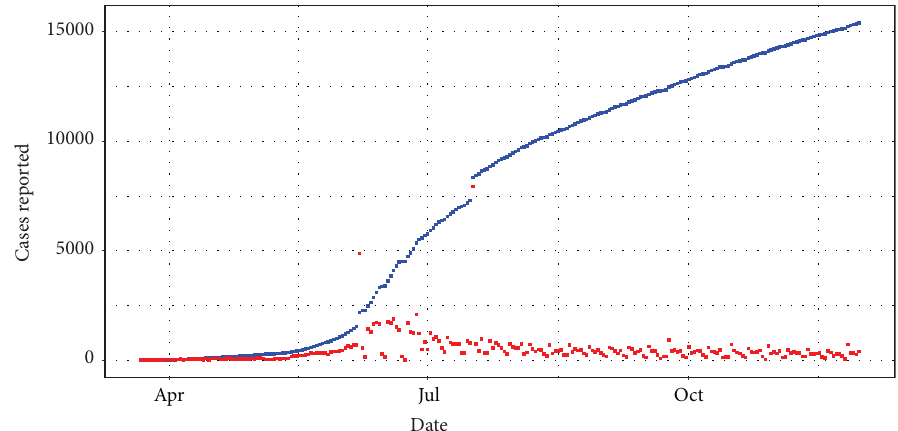
Figure 2: Cumulative and daily number of deaths from COVID-19 in Chile from March 22 to November 30, 2020. Cumulative death cases are shown in blue. In red, the daily number of deaths is recorded, amplifed in an appropriate amount to be able to appreciate them better.